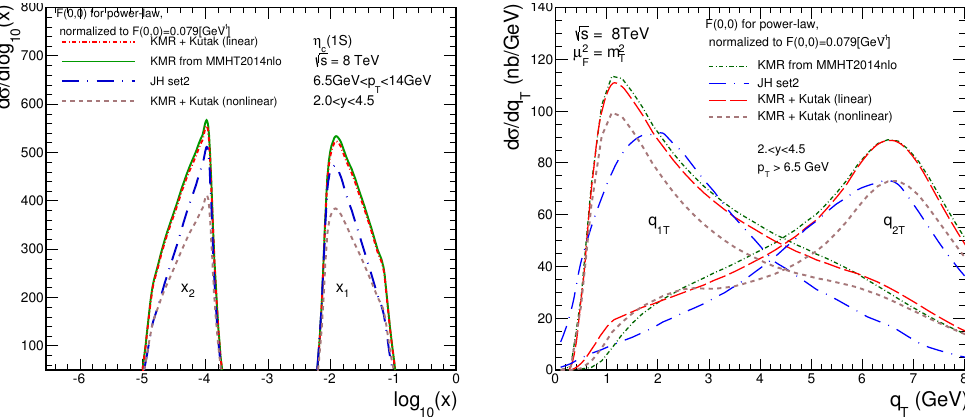
Figure 3 . Distributions in log ( x 1 ) or log ( x 2 ) (left panel) and distributions in q 1 T or q 2 T (right 10 10 panel) for the LHCb kinematics. Here the di(cid:11)erent UGDs were used in our calculations. Here we p show an example, where s = 8